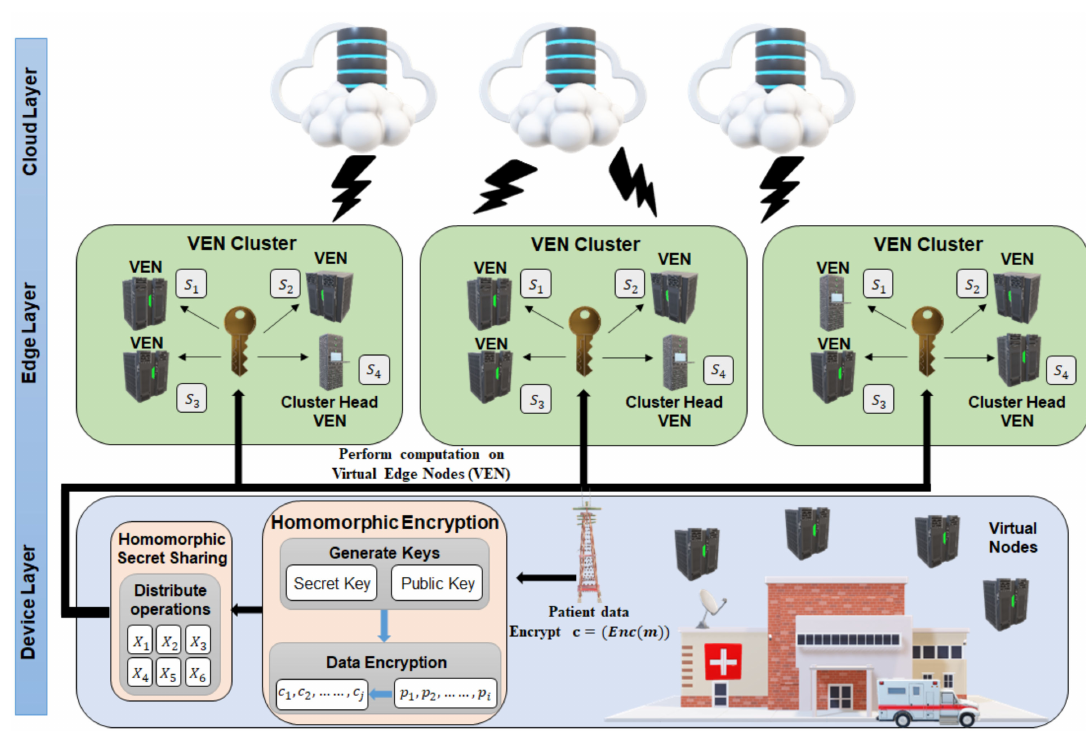
Figure 1. Proposed scheme